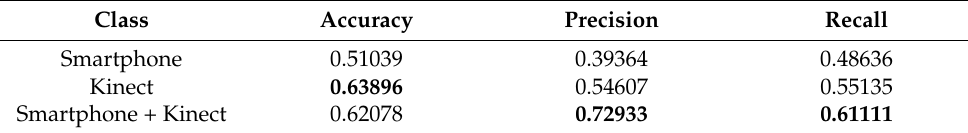
Table 1. The LSTM results in terms of classification Accuracy, Precision, and